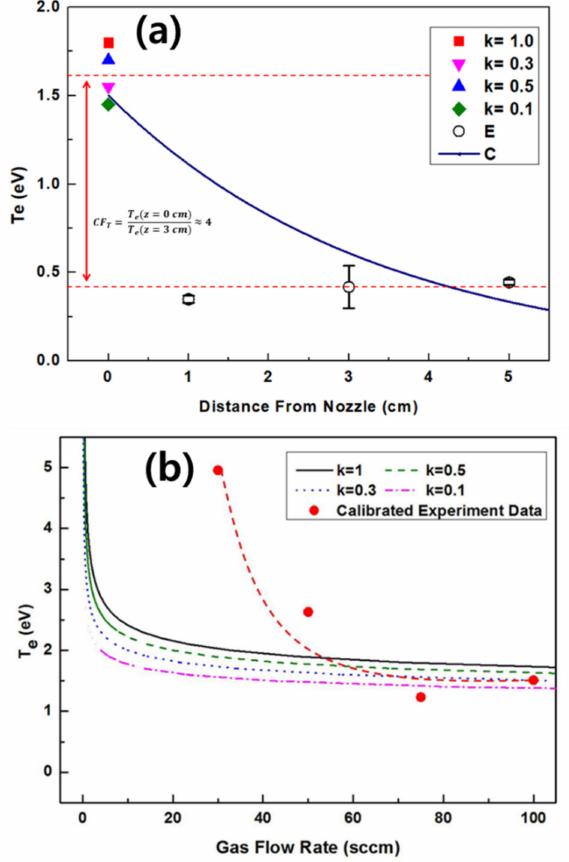
Figure 6. The T e profiles: ( a ) according to distance from nozzle (argon gas flow rate: 75 sccm) to calibrate position difference for correct comparison of numerical calculation results with experiment data and ( b ) comparison of numerical calculation results with calibrated experiment average values of 100–150 mA as function of gas flow rates compensated for position difference ( z : 0 cm). (E) and (C) in this figure legend are experiment and calculation results by Equation (8),